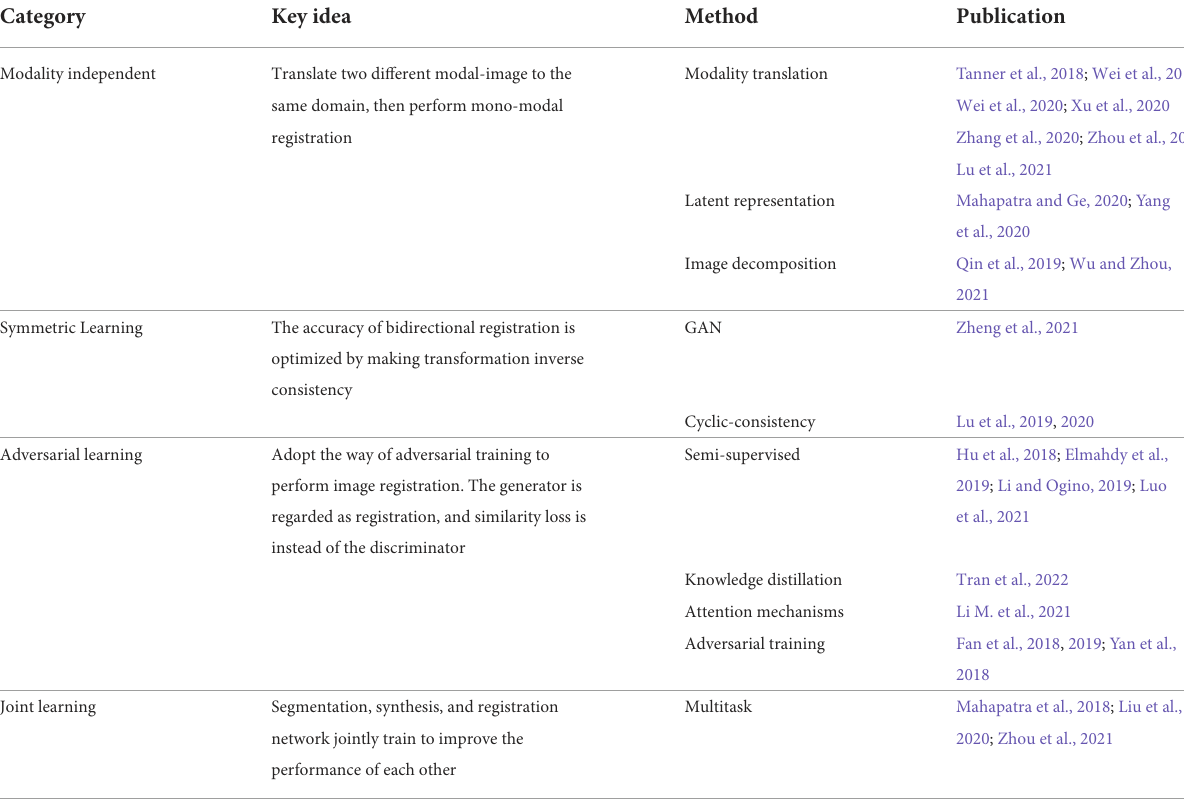
TABLE 1 A category overview of biomedical image registration methods using